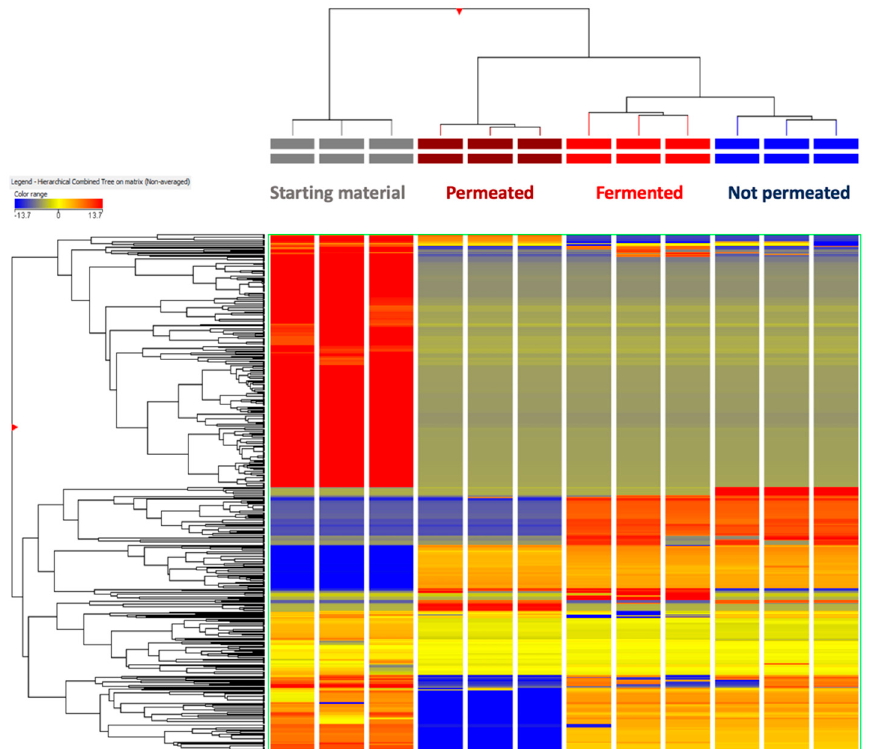
Figure 2. Unsupervised hierarchical cluster analysis of phenolic and sesquiterpene lactone profiles gained from starting (undigested) material, fermented samples (at 20 h of in vitro large intestine fermentation) as well as permeated and not permeated fractions from Caco-2 cellular trial: The clusters were produced from the fold-change based heatmap, assuming a Euclidean distance.